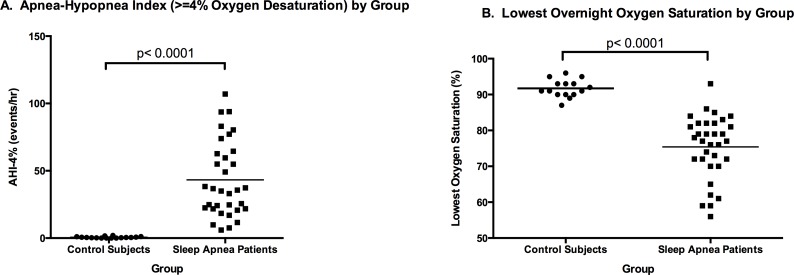
Sleep Apnea Severity between Control Subjects and Affected Patients.A depicts the individual apnea-hypopnea indices (average number of respiratory events with at least 4% oxygen desaturation per hour; AHI-4%) between control versus sleep apneic groups. B depicts the lowest percent oxygen saturation recorded by overnight pulse oximetry between groups. Horizontal lines within each group of data points indicate the group mean.